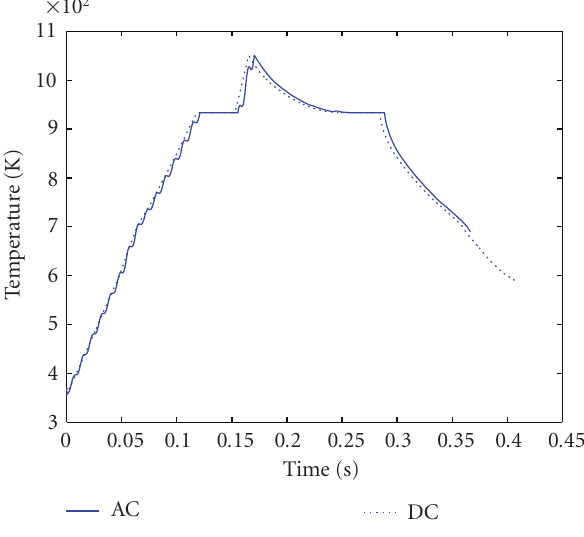
Figure 4.9. Example 3: temporal variation of interface temperature for AC and DC current